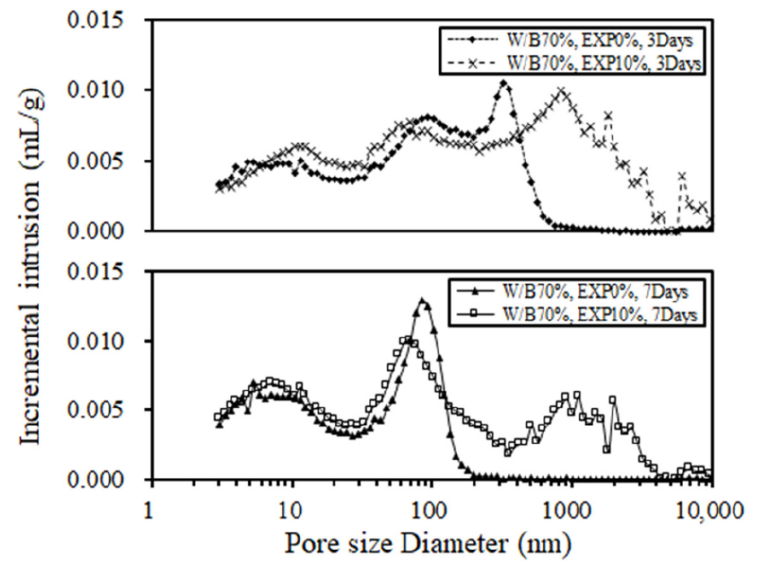
Figure 7. Comparison of incremental intrusion vs. pore size in specimens according to the W/B ratio and expansive addition